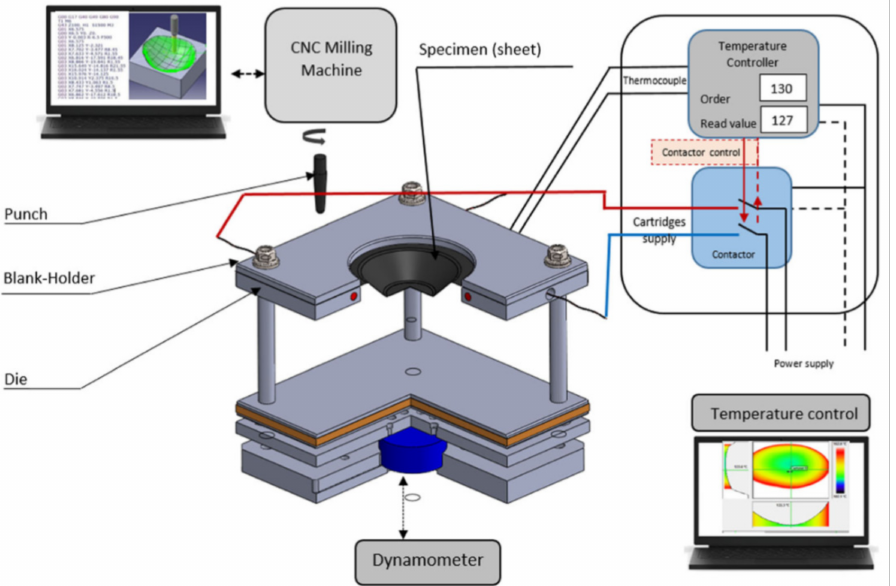
Figure 6. Scheme for warm SPIF (reprinted with permission from [79]; copyright © 2018, Springer- Verlag London Ltd., part of Springer Nature).